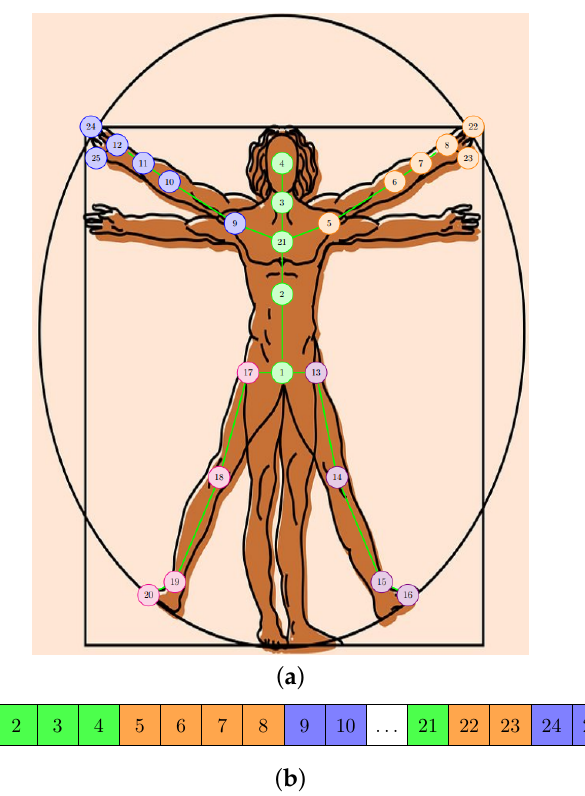
Figure 1. The representations used for the human skeleton in the proposed approach. ( a ) The graph composed of the points of articulation. ( b ) Linear representation of